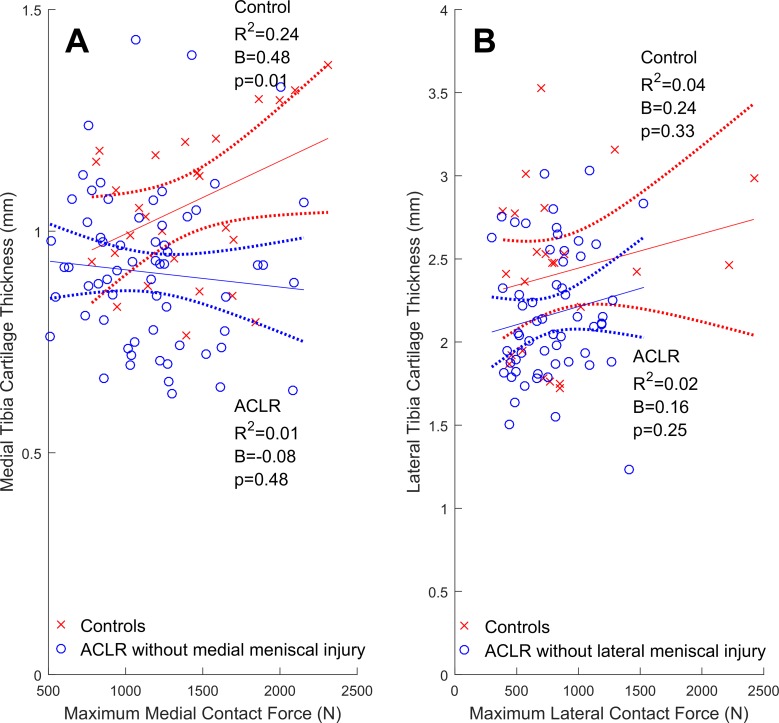
Tibial articular cartilage thickness (mm) regressed onto maximum contact forces (N) with 95% confidence intervals (dotted lines) for isolated ACLR and healthy control knees in the (A) medial and (B) lateral compartments. ACLR, anterior cruciate ligament reconstruction.